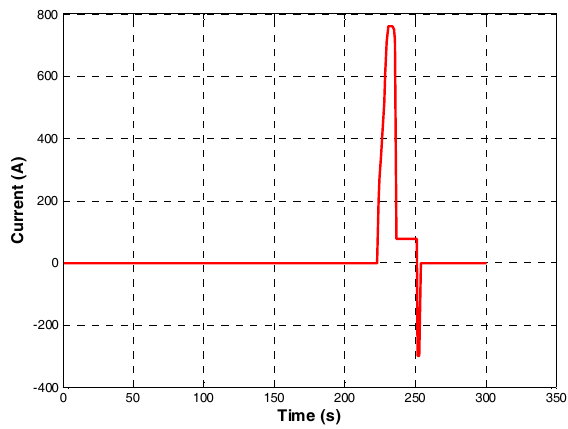
Figure 11. Voltage trend in the node 10 during the movement of the tram along the track.